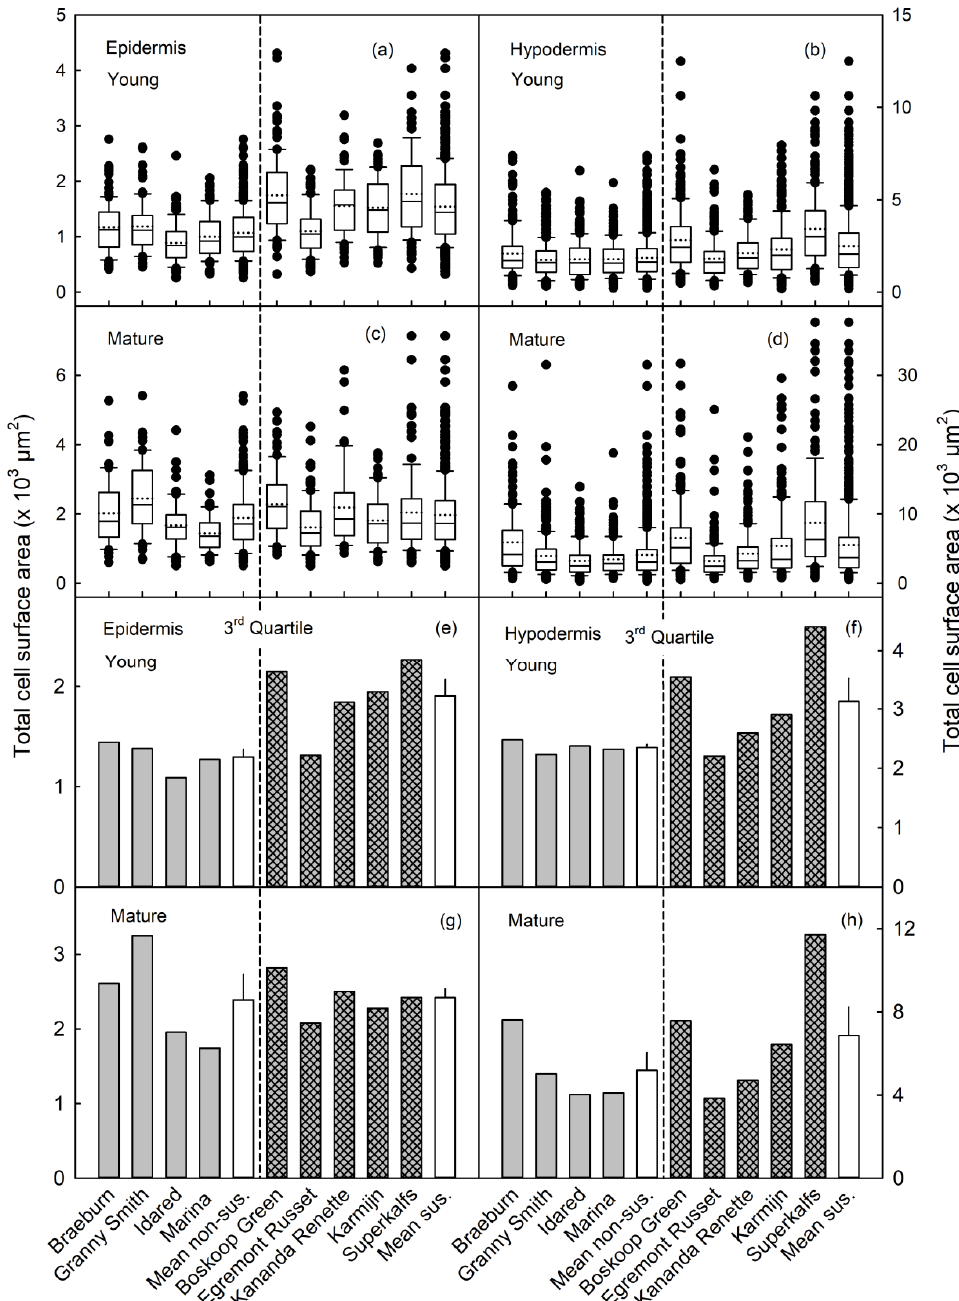
Figure 5. Boxplots ( a – d ) of total surface area of epidermal ( a , c ) and hypodermal ( b , d ) cells of young (28–35 days after full bloom) ( a , b ) and mature ( c , d ) fruit of selected russet non-susceptible ( left ) and susceptible ( right ) groups of apple cultivars (separated by a vertical dashed line). Values of the 3rd quartile of the total surface area ( e – h ) of epidermal ( e , g ) and hypodermal ( f , h ) cells of young ( e , f ) and mature ( g , h ) fruit of selected russet non-susceptible ( left ) and susceptible ( right ) groups of apple cultivars (separated by a vertical dashed line). The grand mean for the russet non-susceptible group is referred to as “Mean non-sus”, and that of the russet susceptible group referred to as “Mean sus”. Results for ‘Idared’ and ‘Karmijn’ were taken from Figure 3. The numbers of replicates were 68–145 (epidermis) and 172–331 (hypodermis) cells in young and 57–97 (epidermis) and 128–205 (hypodermis) cells in mature fruit. Cells were measured in seven fruit per cultivar.